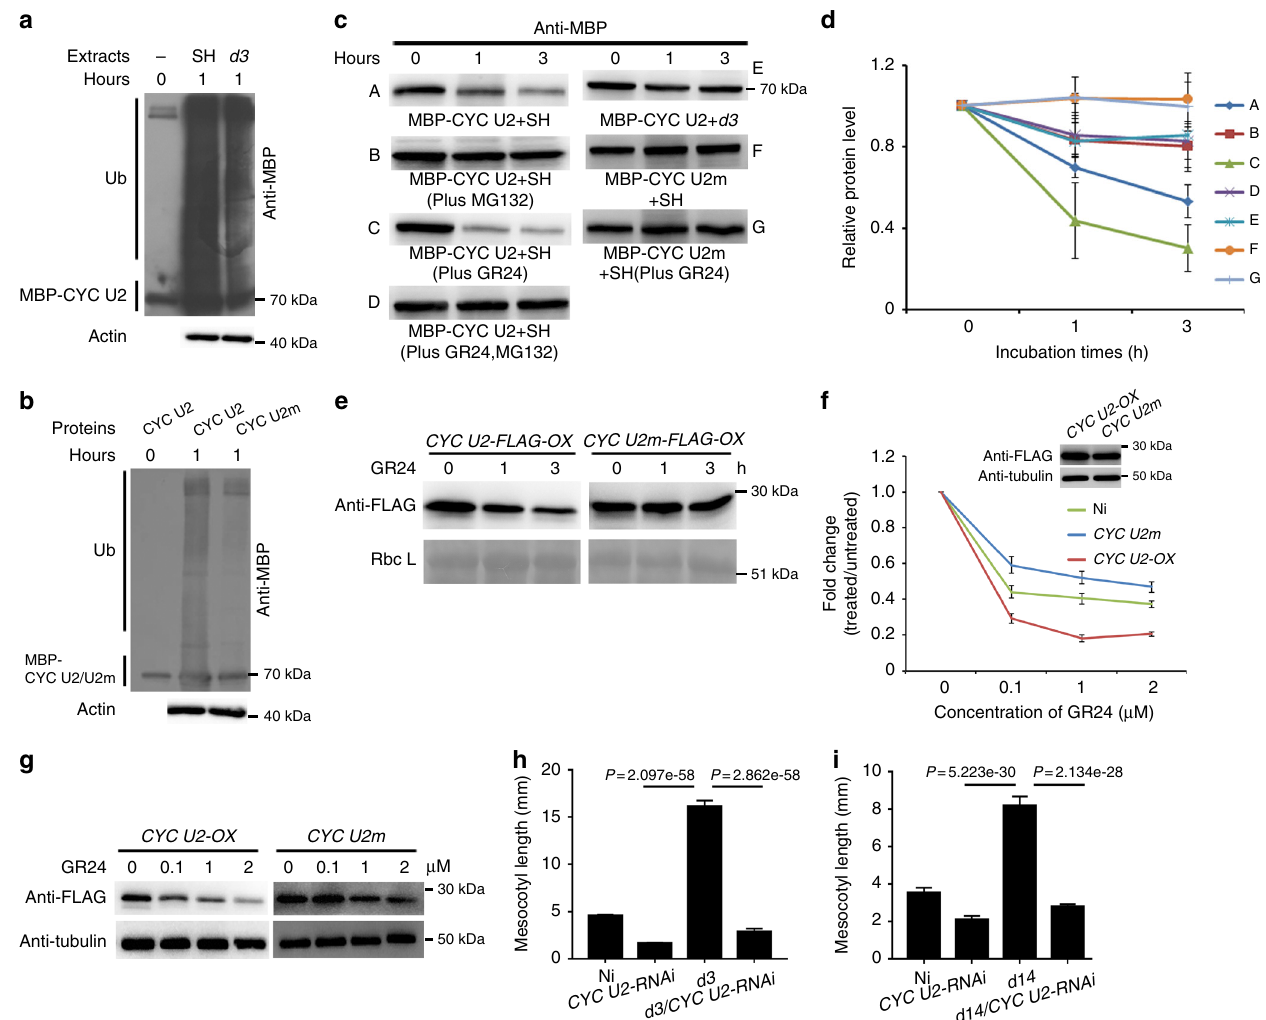
Fig. 5 SL-inhibited mesocotyl elongation depends on the degradation of the OsGSK2-phosphorylated CYC U2 by D3. a The ubiquitination assay of CYC U2 in SH and d3 mutant. Endogenous actin detected with actin antibody showed the equal amounts of crude extracts from SH and d3 plants incubated. SH is the background of d3 . b The ubiquitination assay of CYC U2 and CYC U2m in SH. c The cell-free degradation assays for detecting degradation of CYC U2 and CYC U2m in SH and d3 with or without GR24 treatment. The equal recombinant proteins were incubated with the equal plant crude extracts. d Quanti fi cation analysis for c . The relative levels of MBP-CYC U2 and MBP-CYC U2m incubated with the indicated plant extracts at 0 h were de fi ned as “ 1. ” The degradation assay has been independently repeated for three times (means ± SD). e The protein levels of CYC U2-FLAG and CYC U2m-FLAG in the corresponding transgenic rice incubated with 5 µ M GR24 at the indicated time points. Rbc L was used as a loading control. f The sensitivity assays of CYC U2 and CYC U2m transgenic rice responding to SL treatments in mesocotyl length. The close-up view indicates the transgenic rice used in ( f , g with the similar protein level of the transgenic gene without GR24 treatment. Error bars are SE ( n = 15). Ni is the wild-type control. g CYC U2-FLAG or CYC U2m- FLAG protein levels in the mesocotyls of CYC U2-OX or CYC U2m transgenic lines from f . Endogenous tubulin detected with tubulin antibody showed equal loading. h The mesocotyl length of the indicated lines for genetic analysis between CYC U2 and D3 . Ni is the wild-type control. Data are mean ± SE. The sample number of Ni, CYC U2-RNAi , d3 , and d3/CYC U2-RNAi are 44, 32, 31, and 50, respectively. i The mesocotyl length of the indicated lines for genetic analysis between CYC U2 and D14 . Ni is the wild-type control. Data are mean ± SE ( n = 35). h , i P values were determined by Welch ’ s t test with